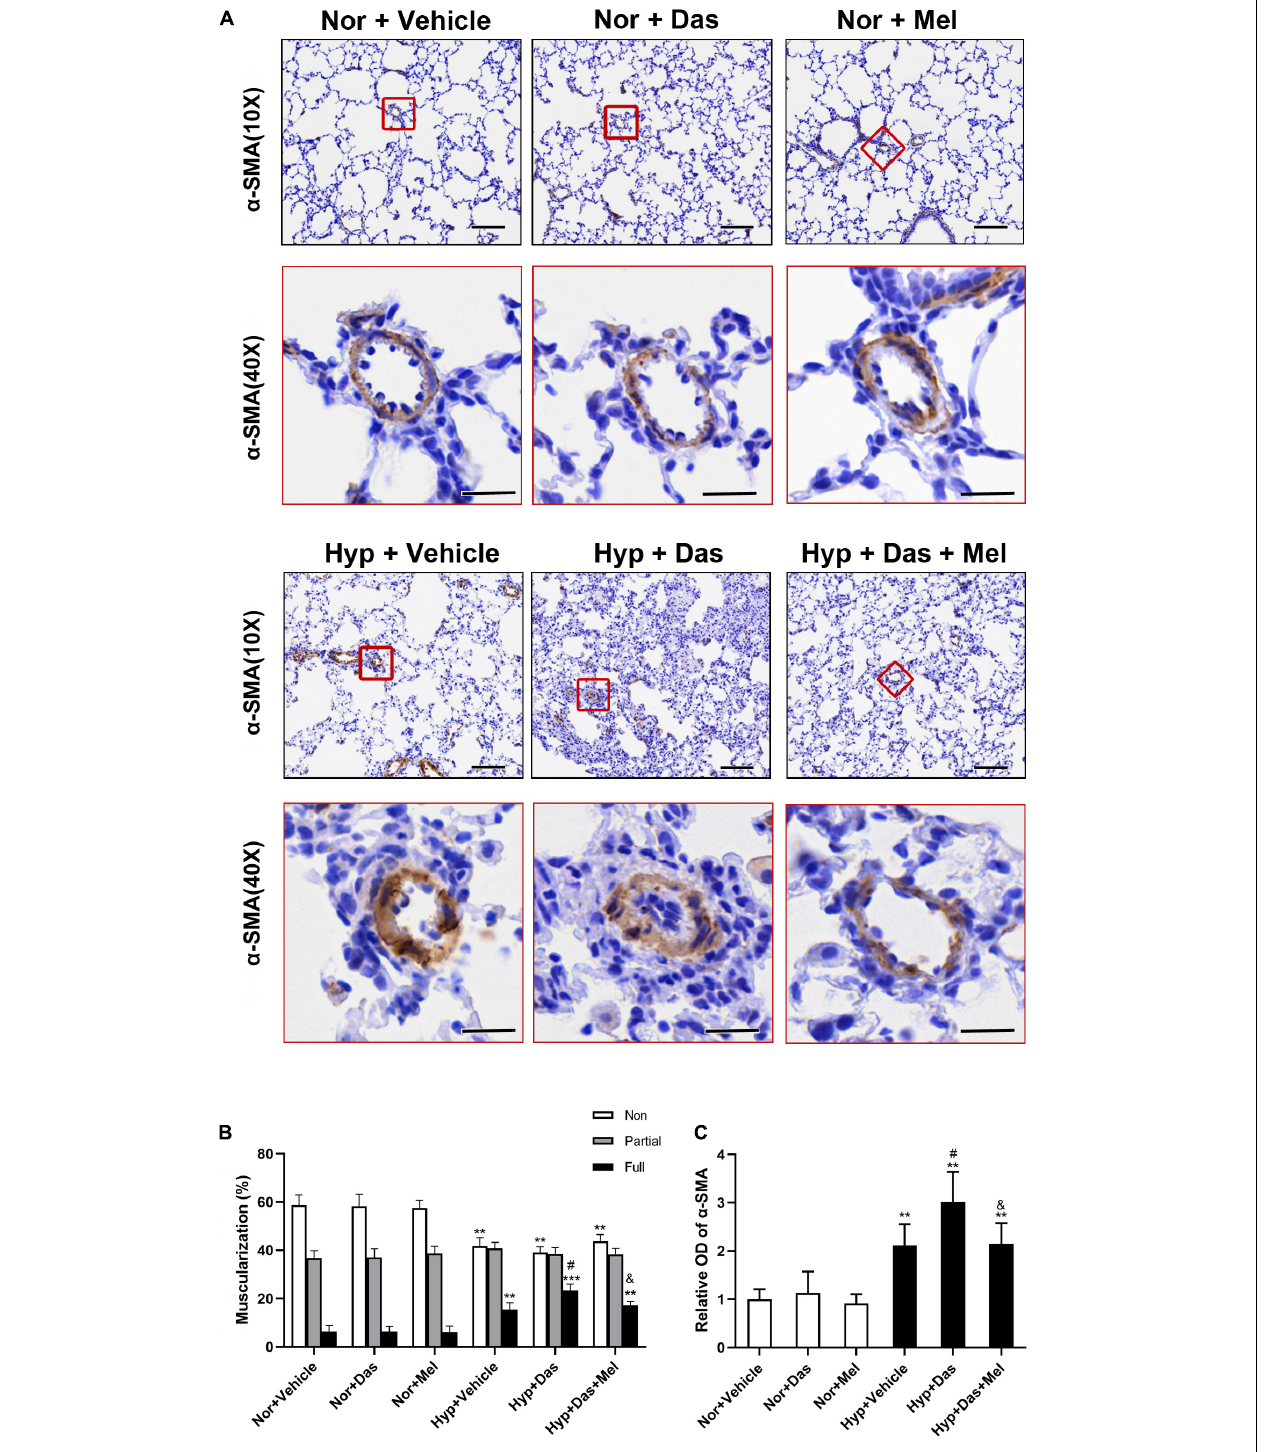
FIGURE 3 | Melatonin attenuates pulmonary arteries muscularization induced by dasatinib under hypoxia. α -SMA (smooth muscle actin) immunohistochemical staining of pulmonary arterioles (original magnification × 10, scale bars: 100 µ m, and original magnification × 40, scale bars: 20 µ m) (A) . The quantitative analysis of the proportion of muscularized pulmonary arteries (sized 25–100 µ m) (B) .The quantitative analysis of OD value of α -SMA immunoreactivity in pulmonary arterioles (C) . Values are means ± SEM, ***P < 0.001, **P < 0.01 compared with Nor + Vehicle group. # P < 0.05 compared with Hyp + Vehicle group. & P < 0.05 compared with Hyp + Das group ( n =